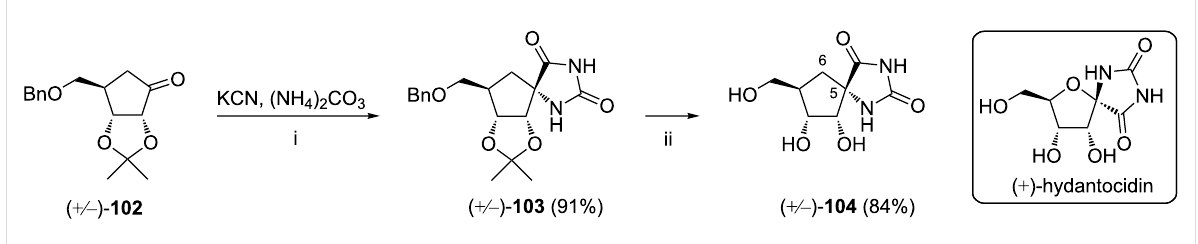
Scheme 43: Reagents and reaction conditions: i. MeOH, H 2 O, 70 °C, 4.5 h; ii. (1) H 2 , 5% Pd/C, MeOH, 55 °C, 5 h; (2) Dowex 50 W, MeOH, H 2 O, rt, 4 h.